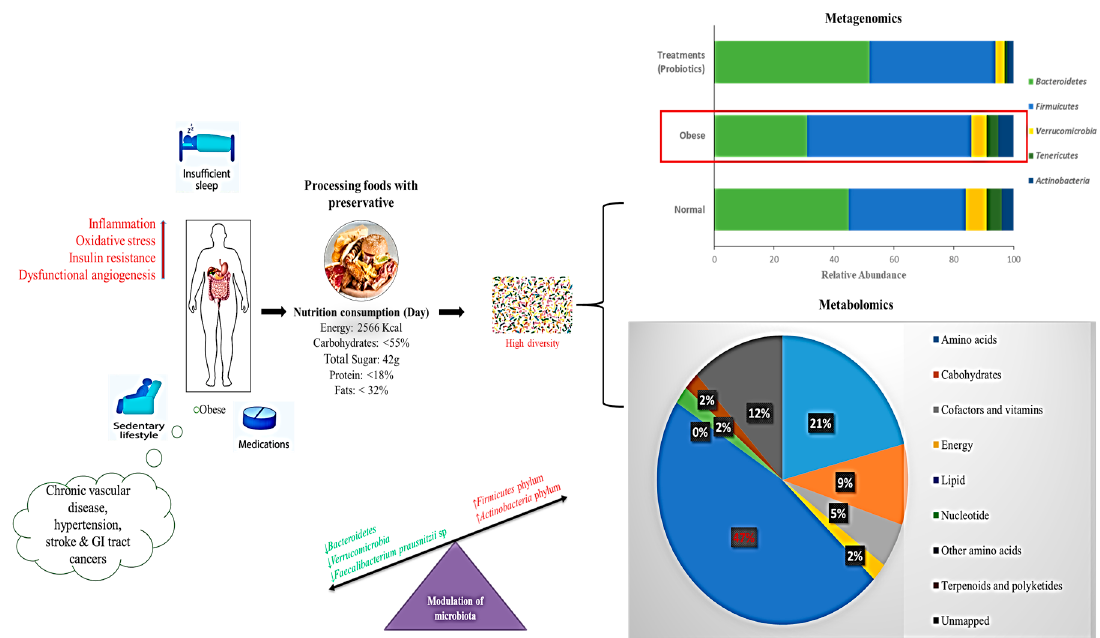
Figure 4. Schematic representation of a Western diet modulating gut microbiota showing interactions between nutrition, energy intake, and modulation of microbiota. Bar chart shows the metagenomics results of operational taxonomic units (OTUs) grouped in phyla. Pie chart shows the percentage of metabolic results influenced by a Western diet (>lipid level); Red arrows indicate increased activity.